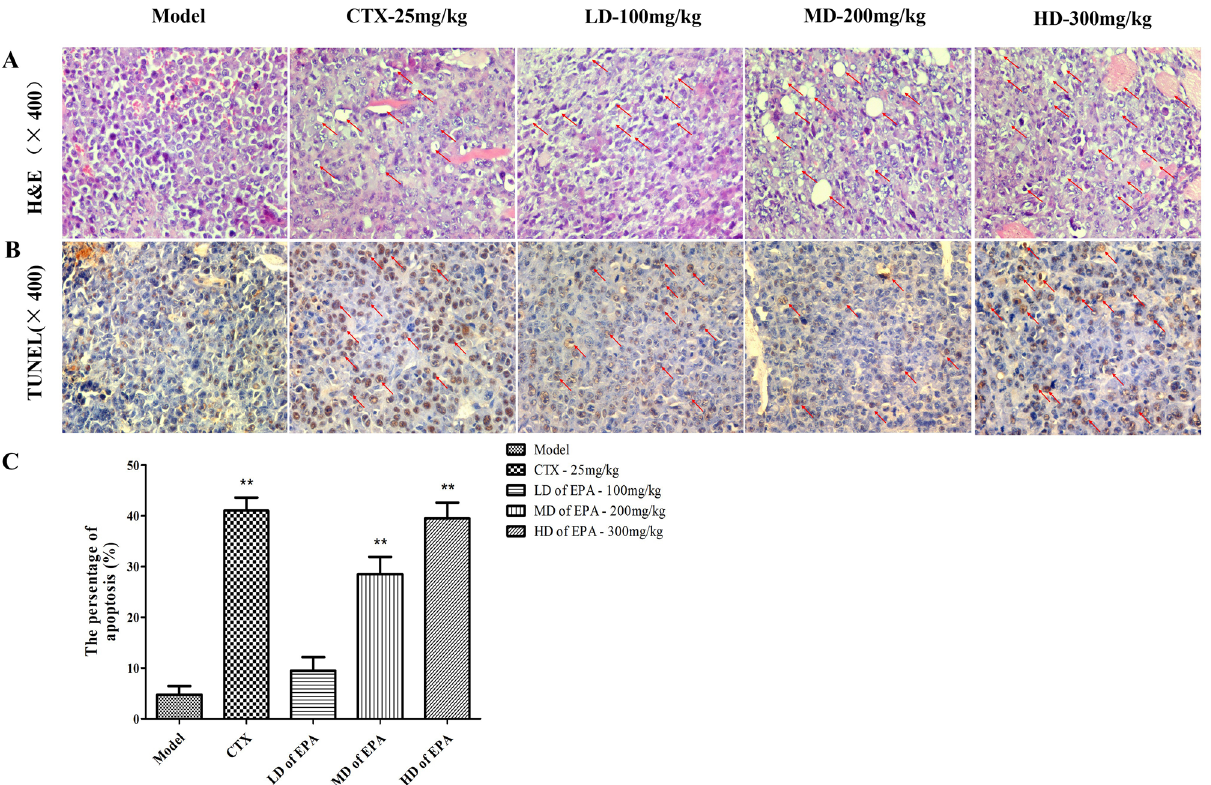
Figure 4. Histological examination of the morphological changes in tumors from H22-bearing mice. Tumor tissues stained with H&E ( A ) (400 ×) TUNEL assay (400 ×) ( B , C